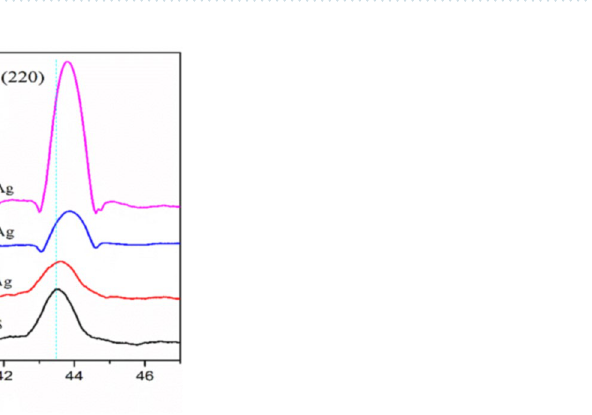
Figure 1. ( a ) XRD spectrum of undoped and Sn doped and ( b ) XRD spectrum of undoped and Ag-doped PbS/ PVA nanocomposites.